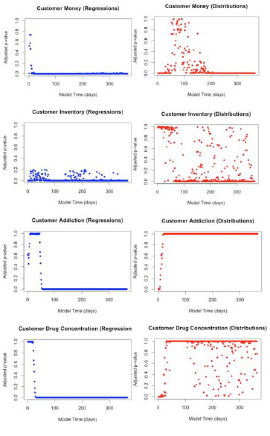
Figure 9. Adjusted p -values for each of the four quantities of interest comparing the reduced model based on distributions and the regression-based reduced model to the full